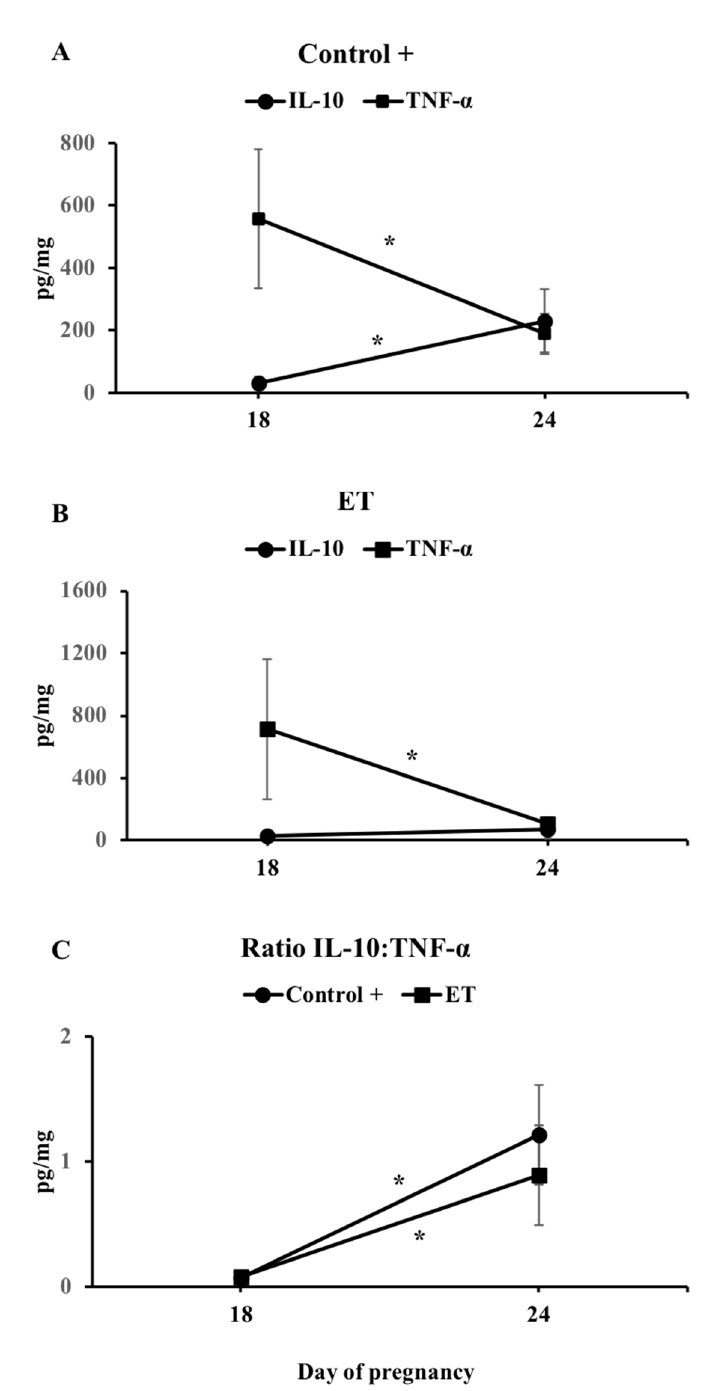
Figure 7. Levels of endometrial IL-10 and TNF- α in C+ ( A ) and ET+ ( B ) groups and IL10:TNF- α ratio ( C ) on D18 and D24 of pregnancy. The ratio was only significantly different ( p < 0.01) when comparing D18 with D24 in both AI+ and ET+ groups. AI: sows artificially inseminated; ET: sows subjected to embryo transfer. Asterisks indicate significant differences among groups ( p < 0.01).